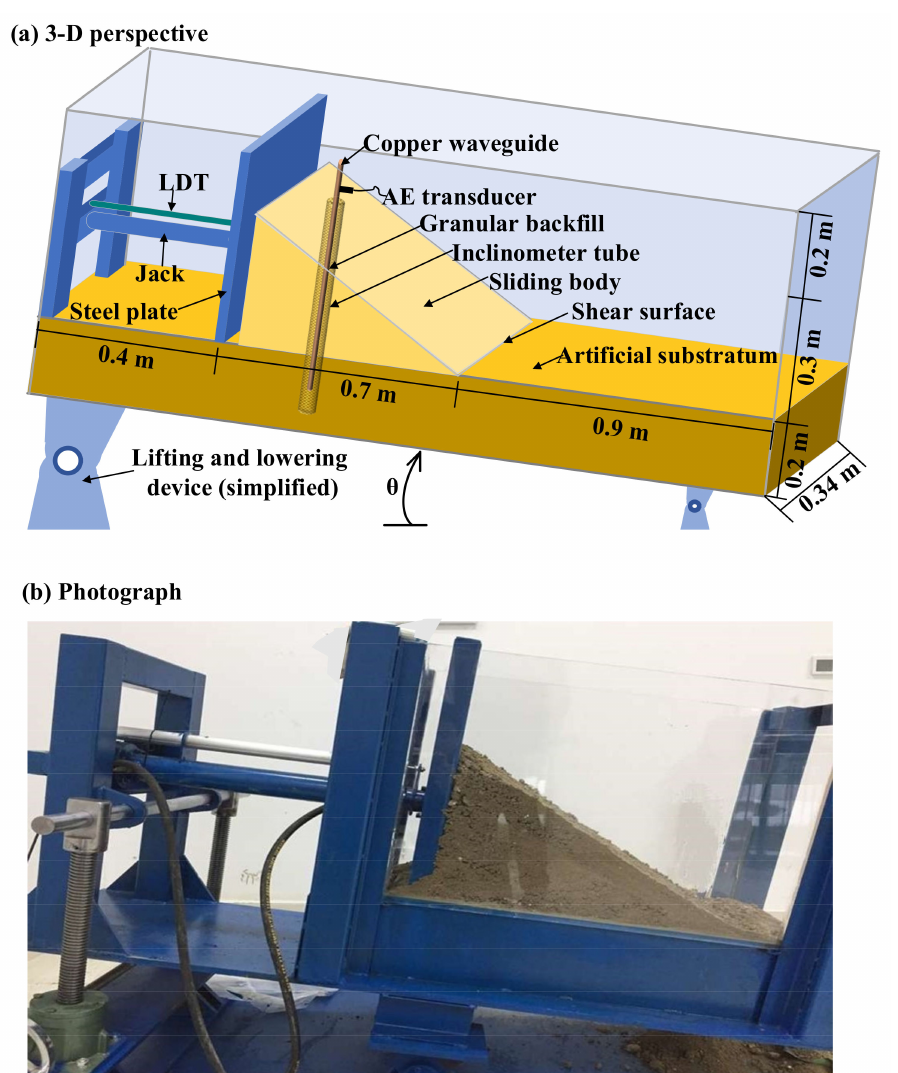
Figure 1. Landslide experiment system. For the 3-D perspective in ( a ), the loading equipment is indicated by the blue part, the artificial substratum is indicated by the brown part, and the sliding body is indicated by the yellow part. ( b ) is a photograph of the experiment system in a